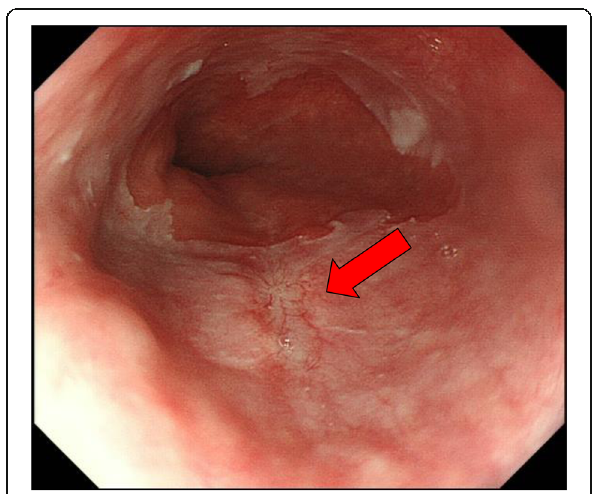
Fig. 4 Endoscopic view (3 months after operation). Red arrow shows scar